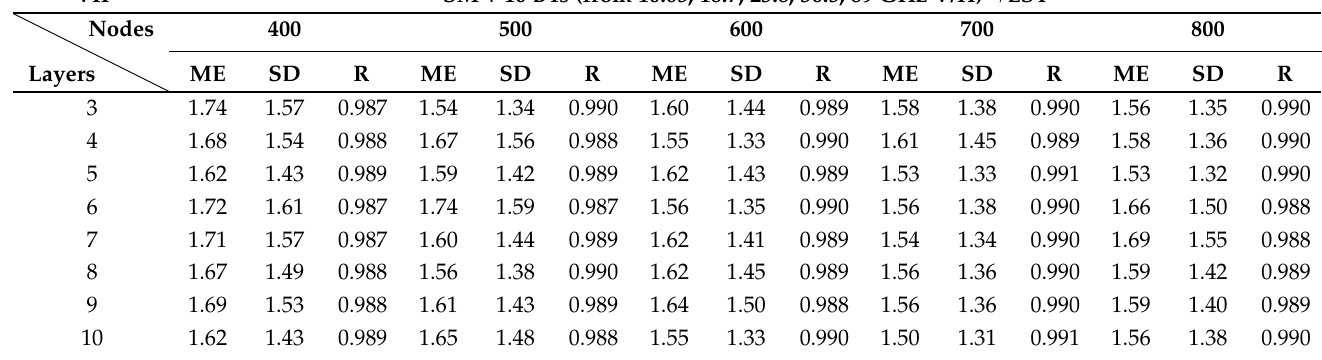
Table 7. SM and ten channels are used to retrieve LST (SM and brightness temperature combination of ten